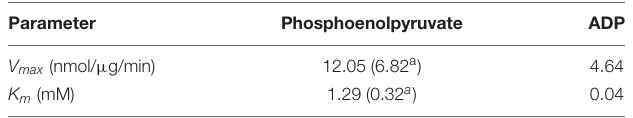
TABLE 1 | rCpPyK enzyme kinetic parameters on substrates.